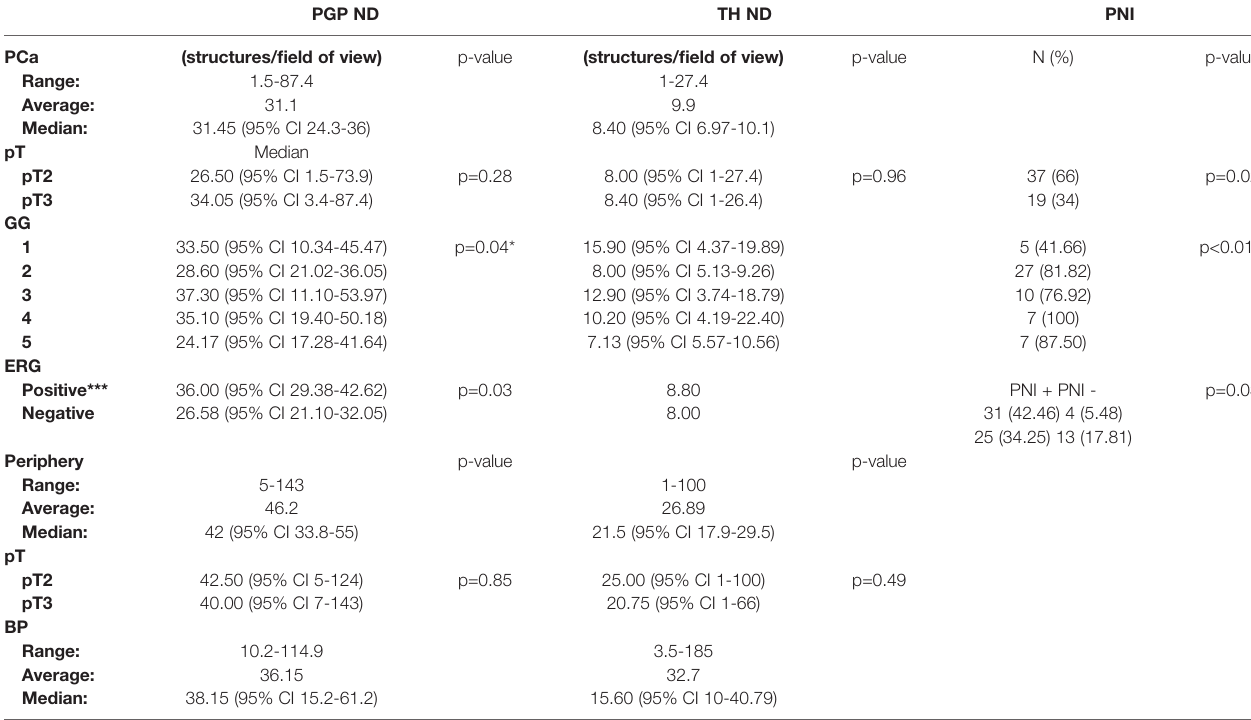
TABLE 2 | ND and PNI in the study group according to Grade Group, pT stage and ERG